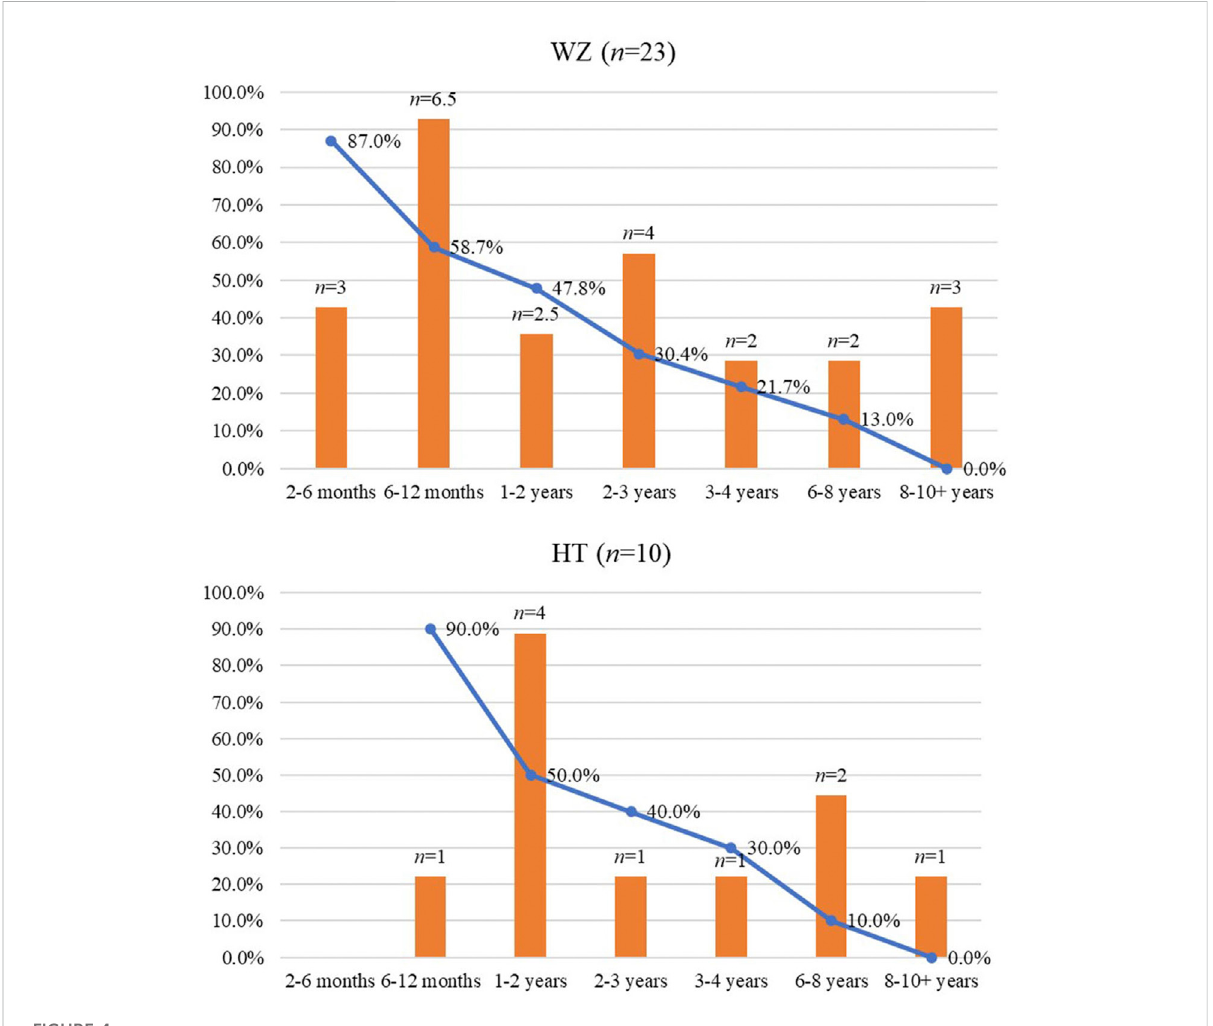
FIGURE 4 Mortality pro fi les and survivorship curves for caprines from the WZ and HT